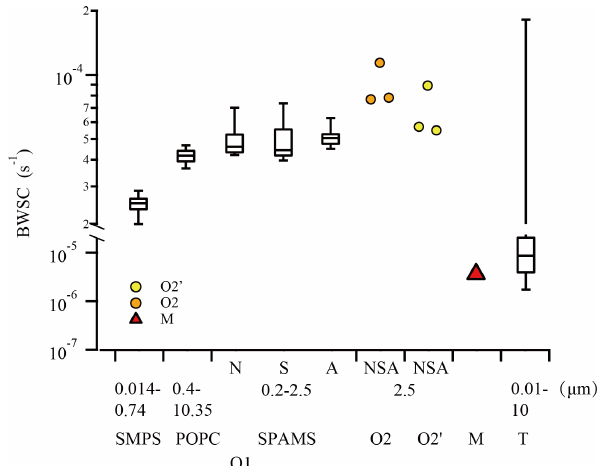
Figure 3. Box and whisker plots of the multi-method estimation of the BWSCs. The top and bottom of the boxes represent the 75th and 25th percentiles, and central lines mean the median BWSCs. The whiskers represent maximum and minimum BWSCs, respectively.